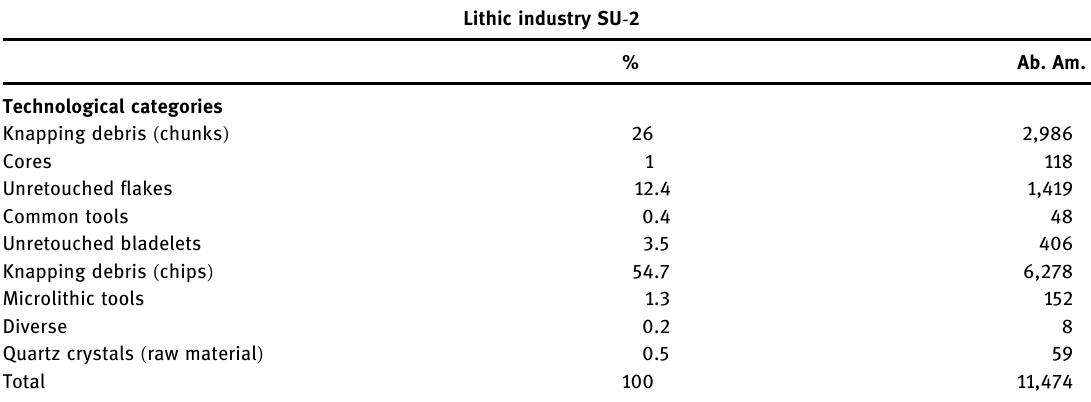
Lithic industry SU - 2 % Ab. Am.